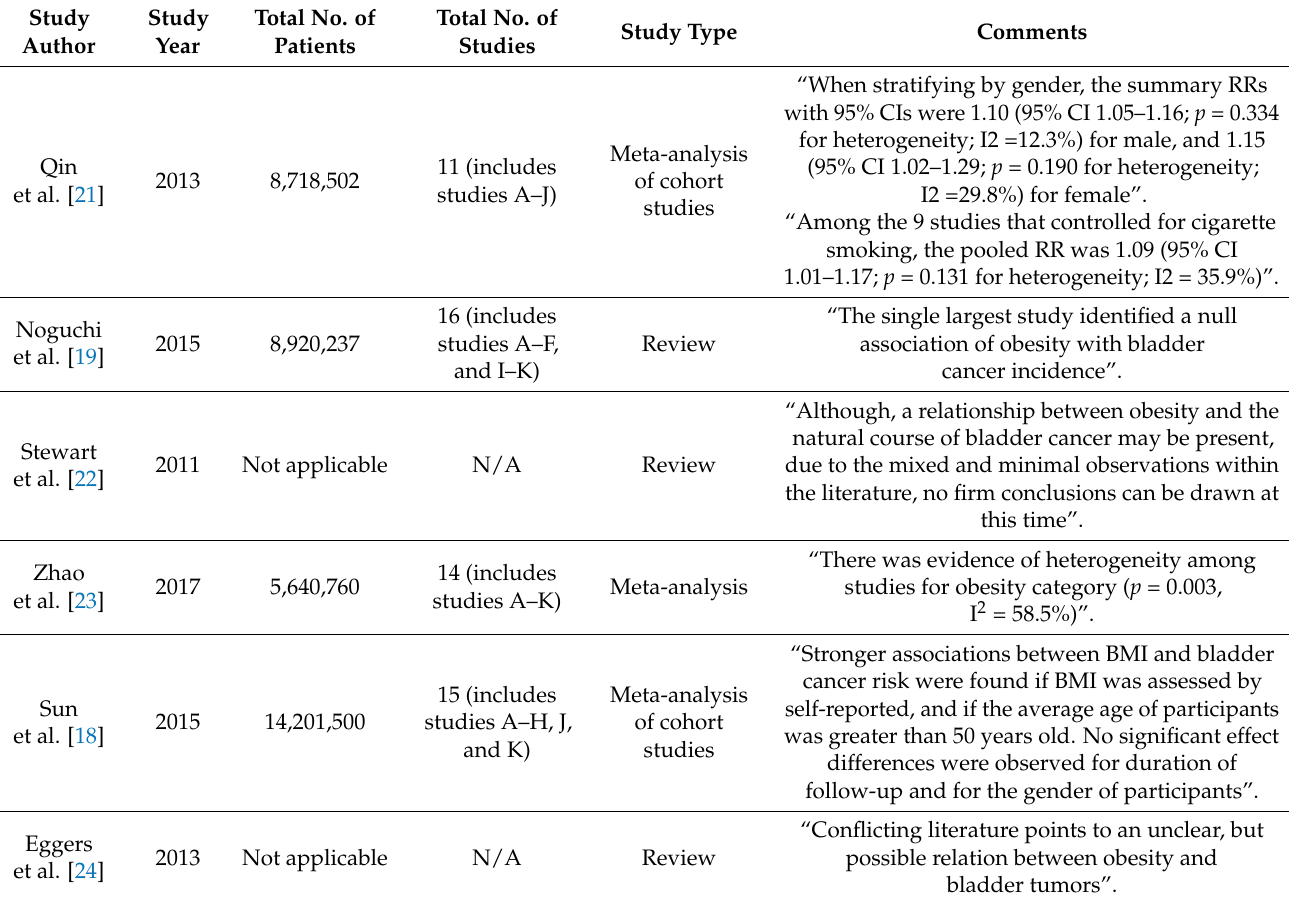
Table 1. Obesity and the incidence of bladder cancer.